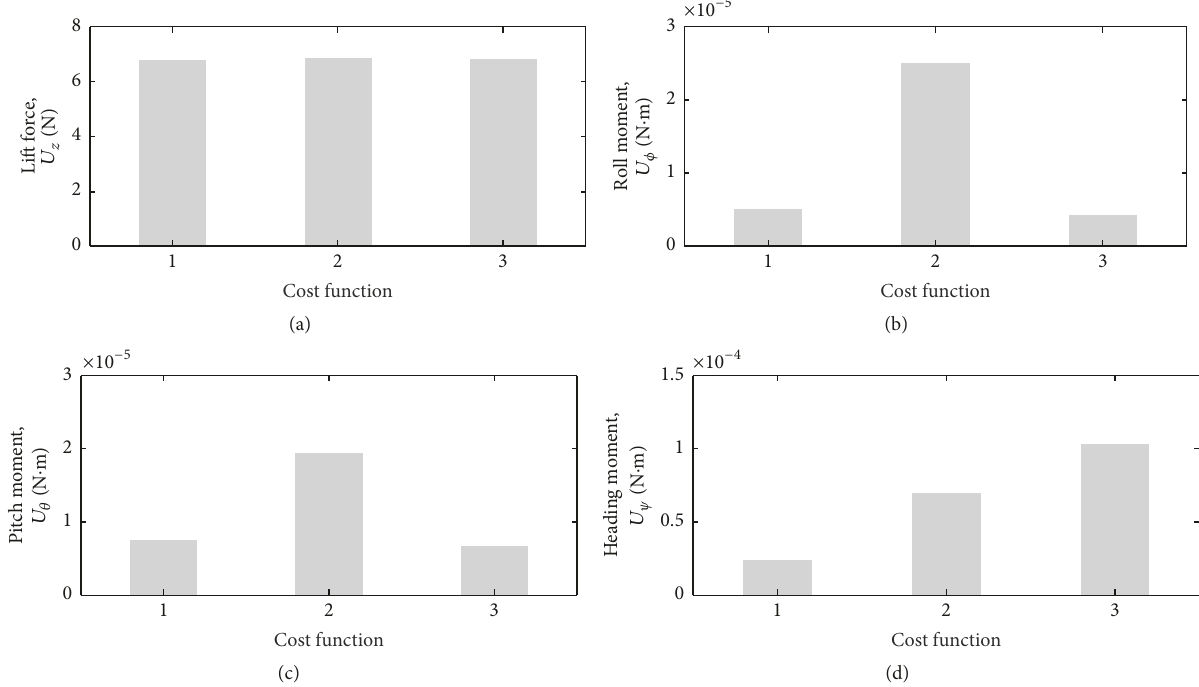
Figure 7: Mean values of (a) lift force and aerodynamical (b) roll and (c) pitch and (d) heading moments,